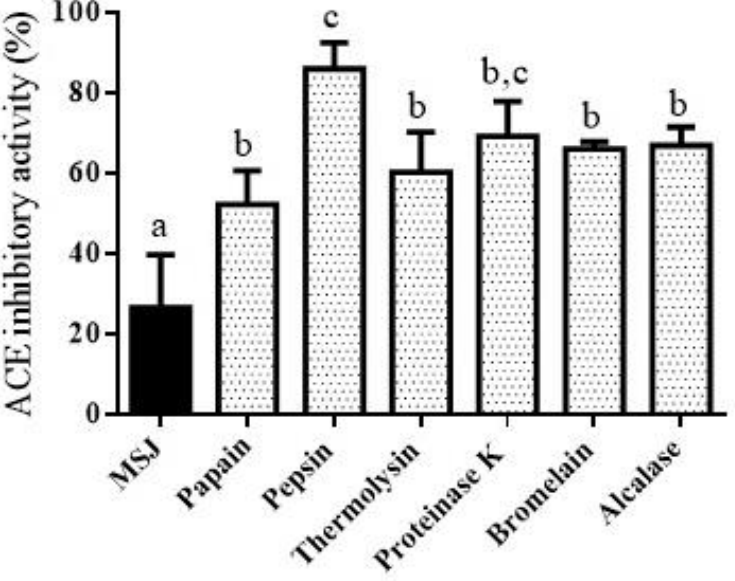
Figure 11. Angiotensin-converting enzyme I (ACE-I) inhibitory activity of mackerel steaming juice (MSJ) and MSJ hydrolysates at 0.1 mg/mL, respectively. Different alphabets on the bar show signifi- cant difference at p <